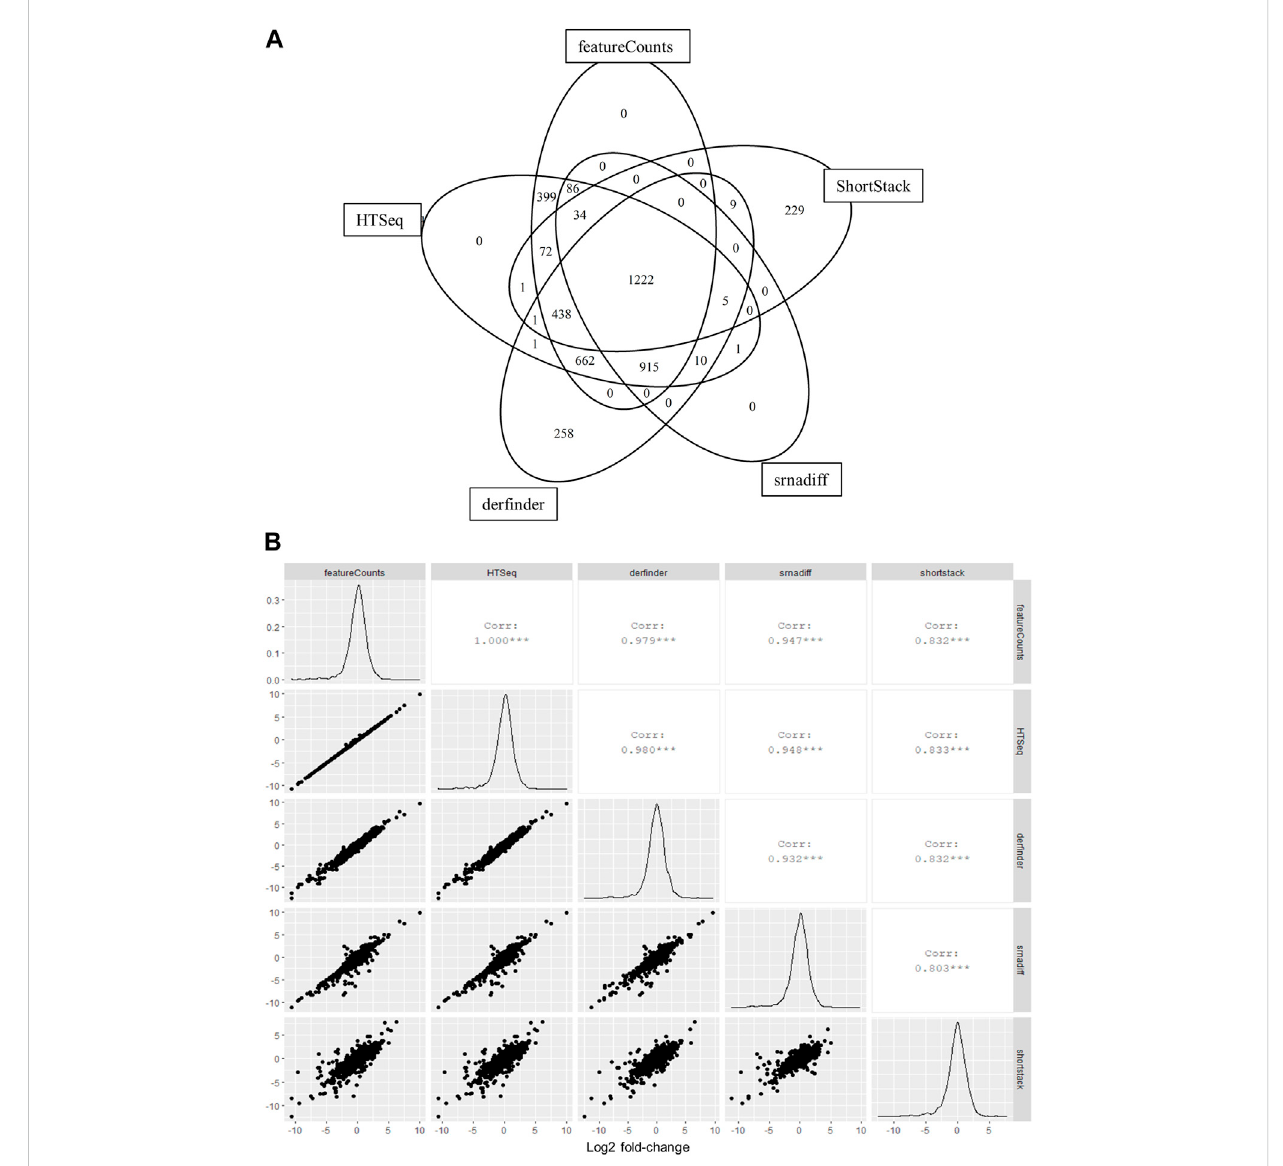
FIGURE 2 Annotation-agnostic tools yield similar results to other read summarization software with real RNA-seq data. (A) Number of features detected by each tool after low-expression fi ltering. EVs were isolated from blood samples of 8 persons with ALS and 6 healthy controls and subjected to RNA- sequencing, as previously described (Saucier et al., 2019). (B) Log2 fold-change values calculated among groups using edgeR and compared for each bioinformatic